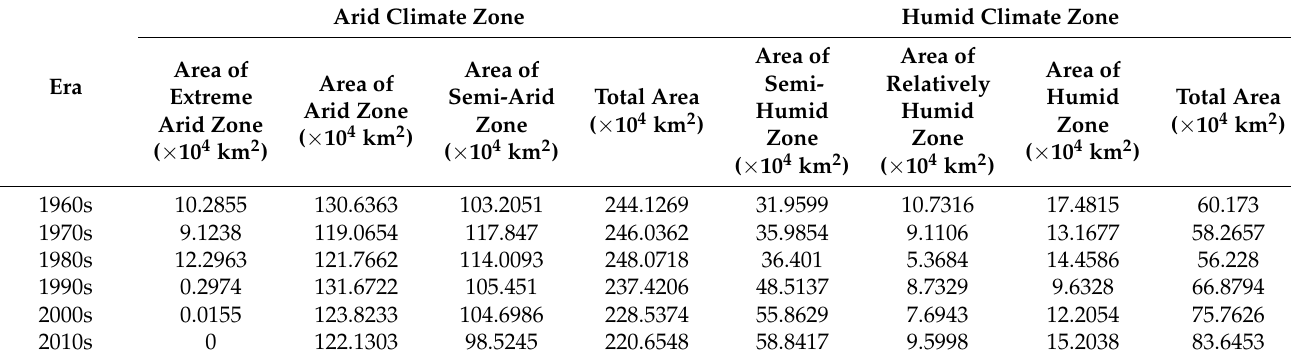
Table 3. The decadal difference of different climate areas in five provinces of Northwest China. Arid Climate Zone Humid Climate Era